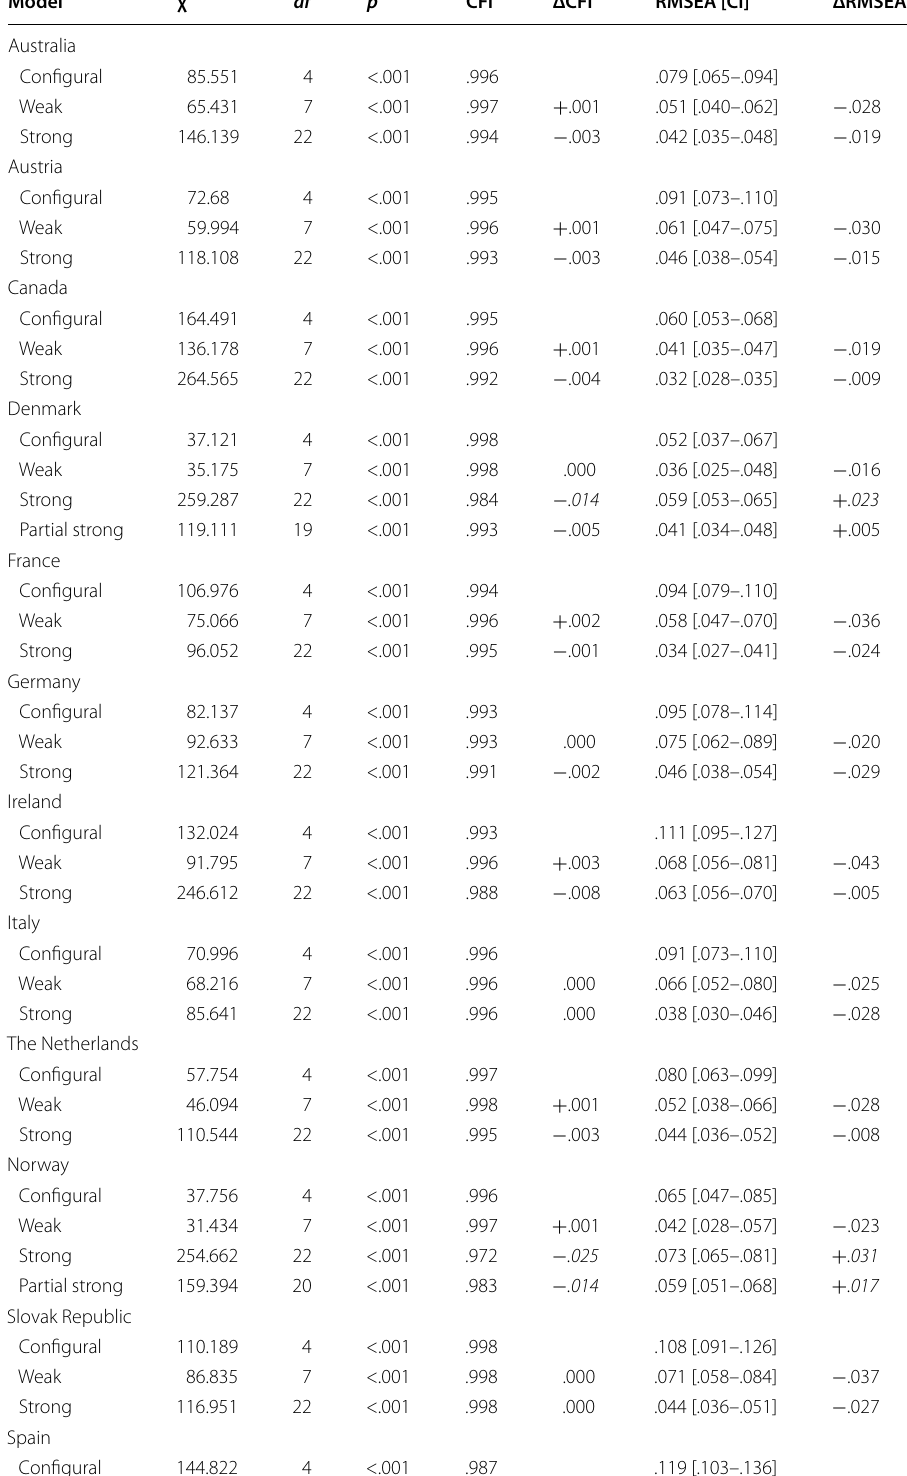
Table 6 Detailed model fit with migration background (i.e., native language same as test language) as grouping